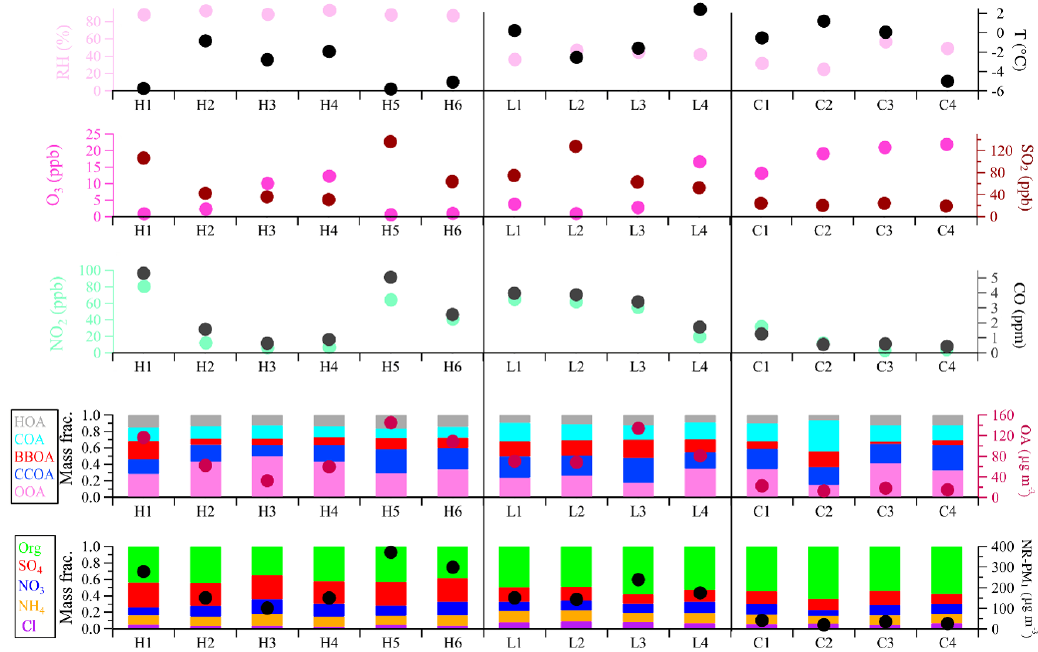
Figure 8. Summary of relative humidity and temperature, gaseous species, organic sources, and NR-PM 1 chemical composition for high-RH (H1–H6) polluted, low-RH (L1–L4) polluted, and clean (C1–C4)